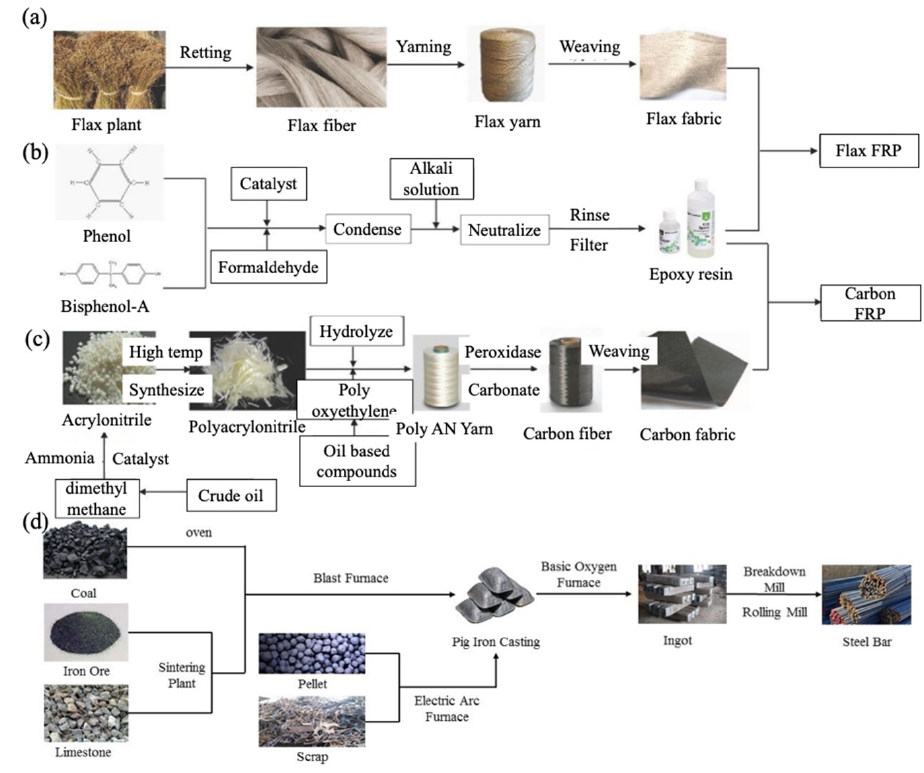
Figure 14. System boundary: ( a ) flax fabric; ( b ) epoxy resin; ( c ) carbon fabric; and ( d ) steel reinforce- ment bar. ment